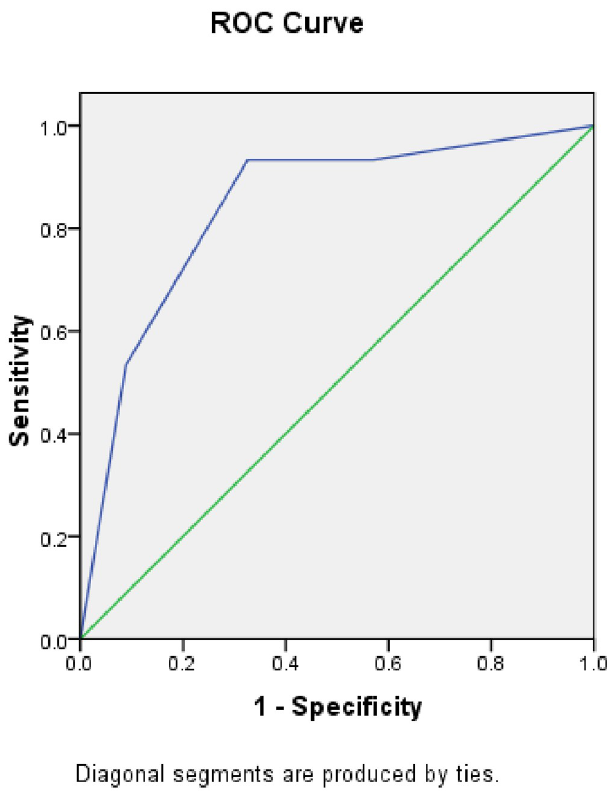
Fig 2. Receiver operator characteristic (ROC) curve for Fibroscan detection of steatosis for stage > 2.